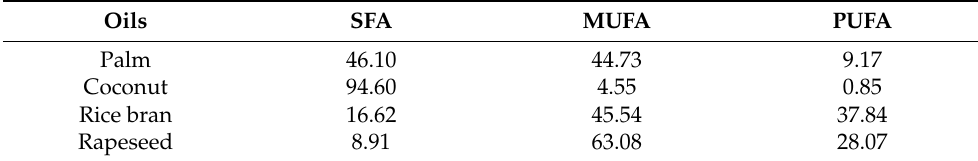
Table 1. Amounts of fatty acids in the studied